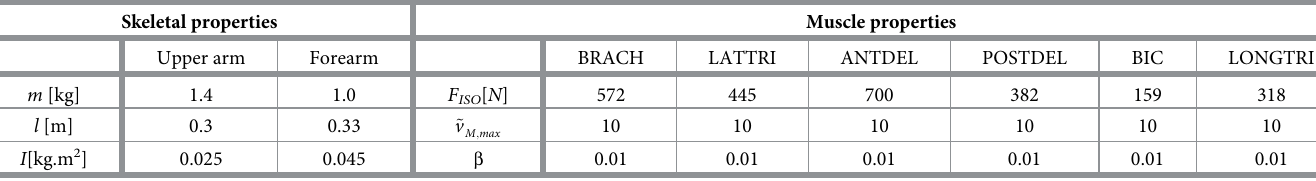
Table 3. Musculoskeletal properties of model for goal-directed reaching. Skeletal